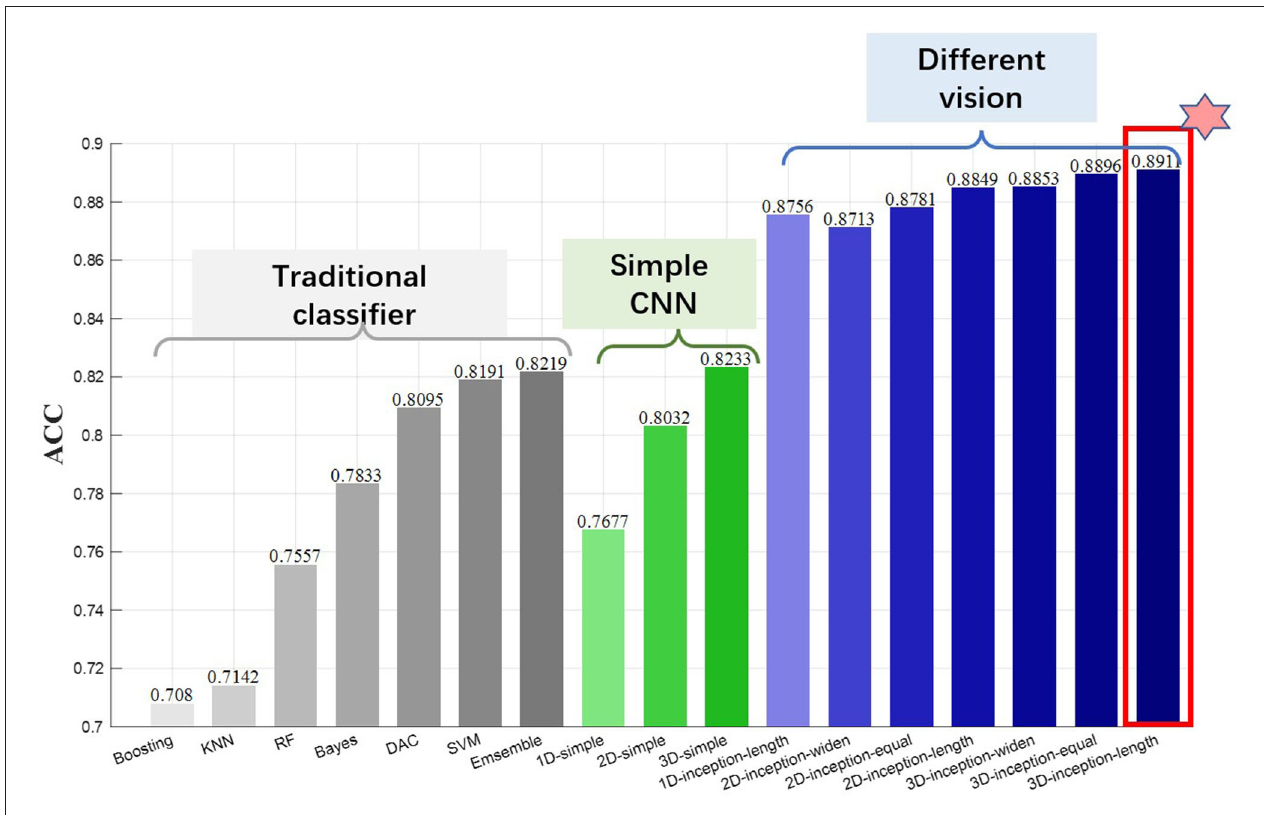
FIGURE 8 | Classification performance of multiple authentication strategies.